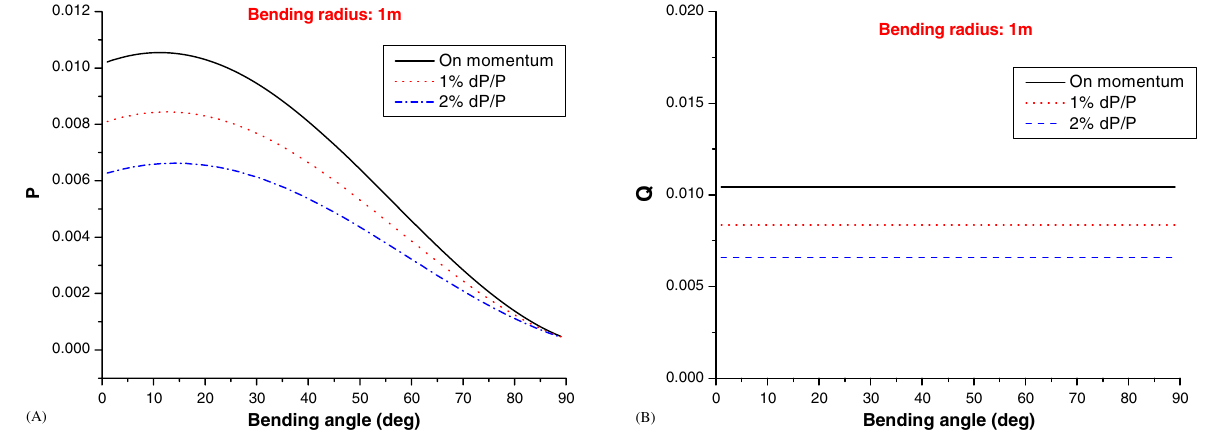
FIG. 8. Variation in P and Q with bending angle for fixed bending radius of 0.96 m. The x i and (cid:3) i are taken as 100 mm and 20 mrad,